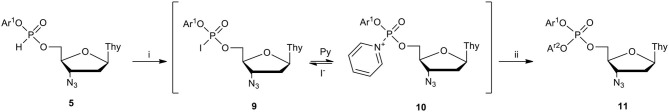
Synthesis of diaryl nucleoside phosphate via oxidative coupling on the example of AZT H-phosphonate 5. (i) I2, 2 molar equiv. in pyridine (1 mM/mL); (ii) Ar2OH, 5 molar equiv.